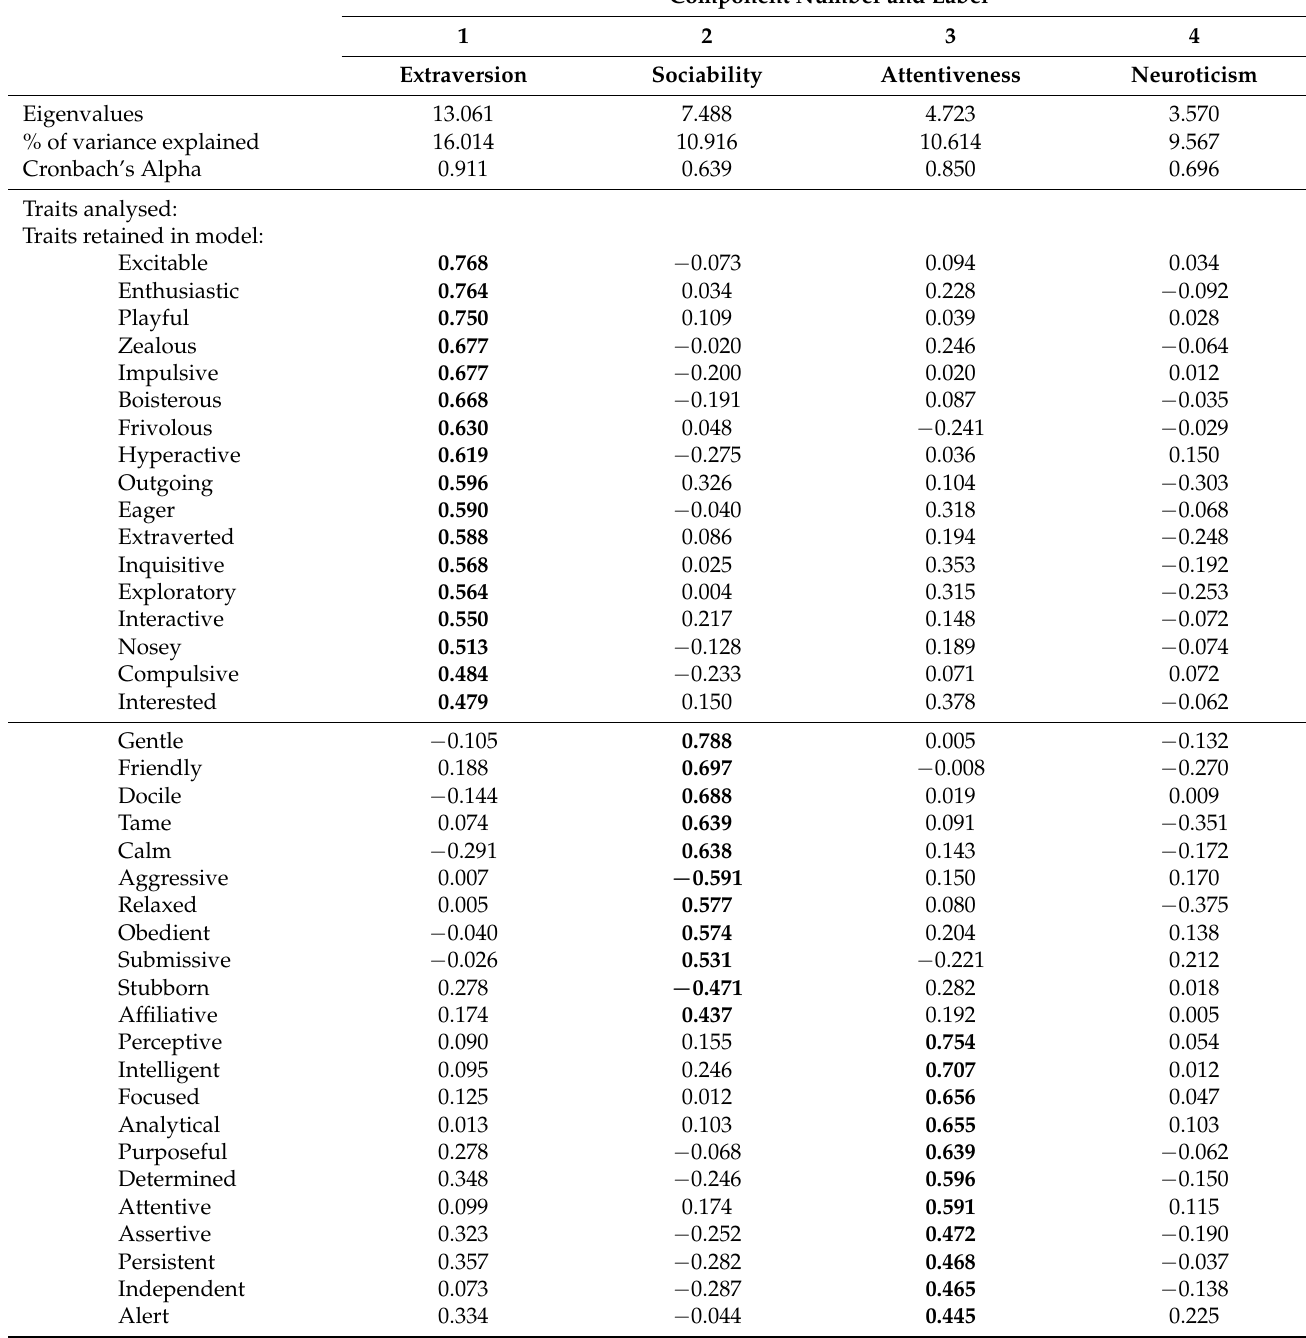
Table 2. Principal component analyses results for 1029 ferrets based on owner ratings of 67 traits. Values of 0.4 or above, or − 0.4 and below, are bolded, indicating a strong loading for that trait on the respective